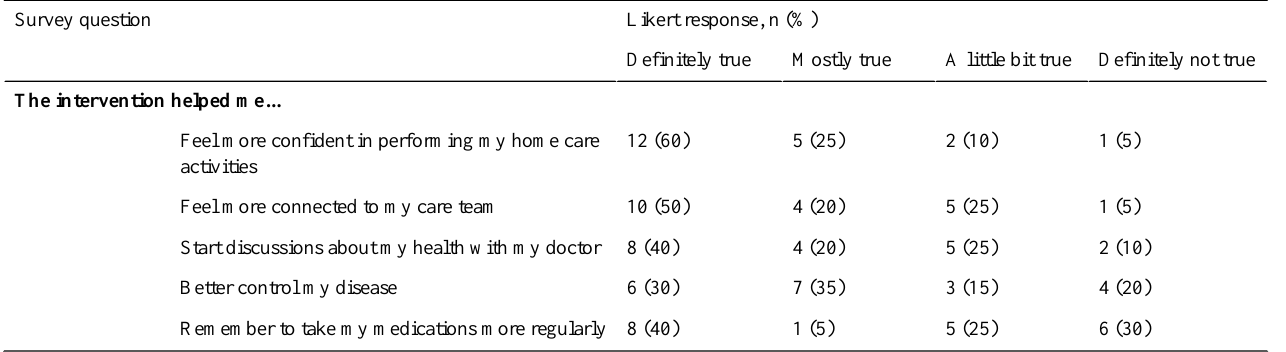
Likert response, n (%)Survey question